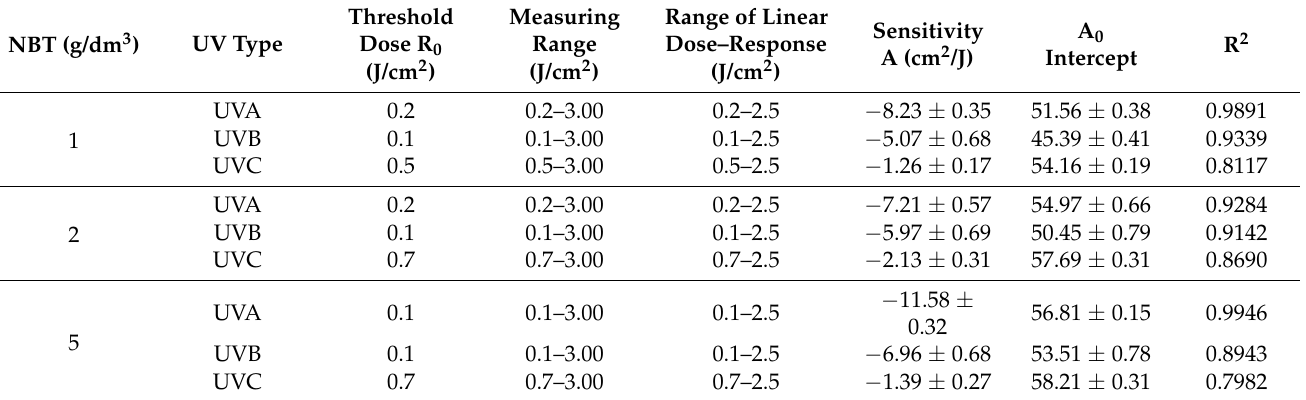
Table 2. Basic characteristics of NBT–Pluronic F–127